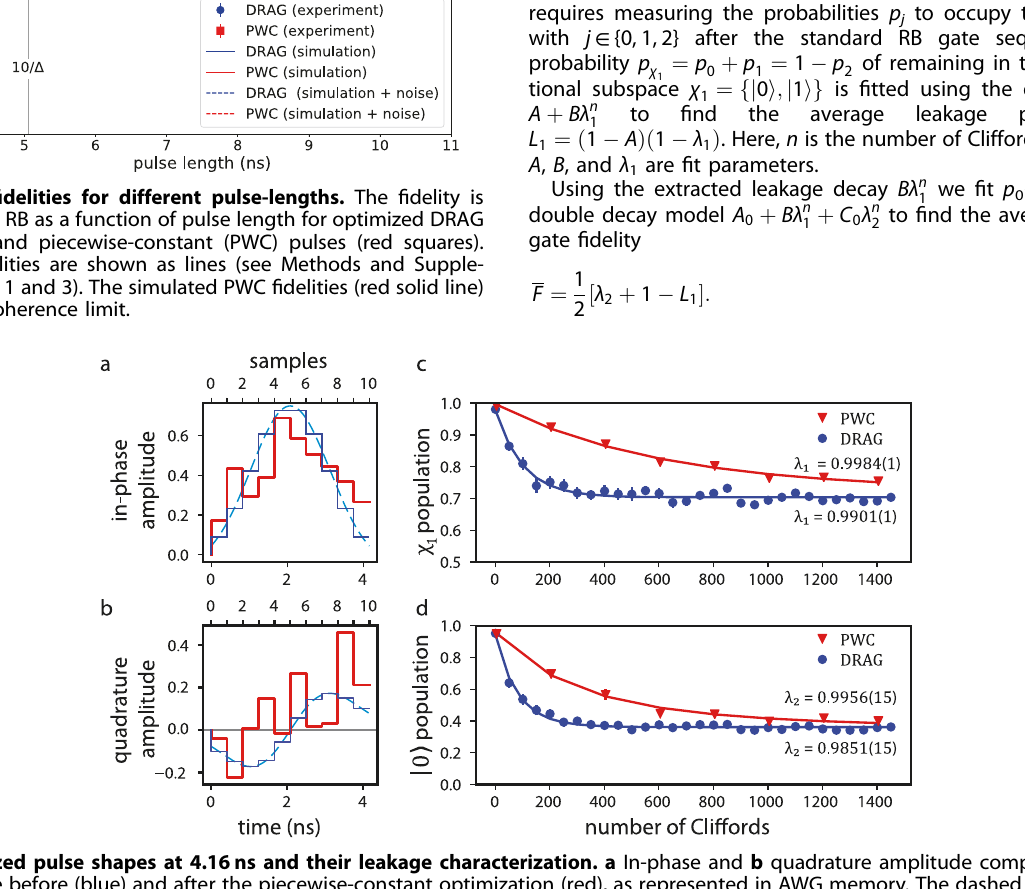
λ λ 1 and 2 for leakage and standard errors,